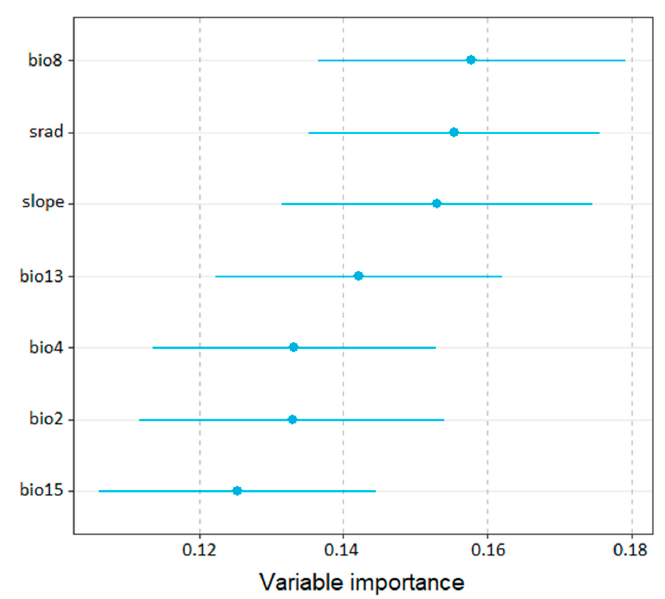
Figure 4. Importance of environmental variables in modeling the distribution of Quercus brantii in the west of